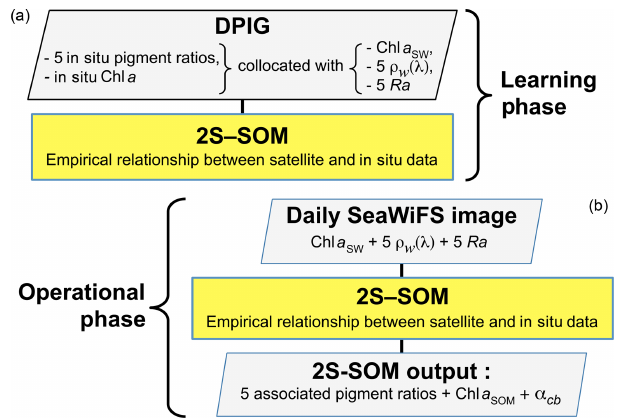
Figure 4. Flowchart of the method: (a) learning phase; (b) opera- tional phase that consists of pigment retrieval and the determination of the block parameters.